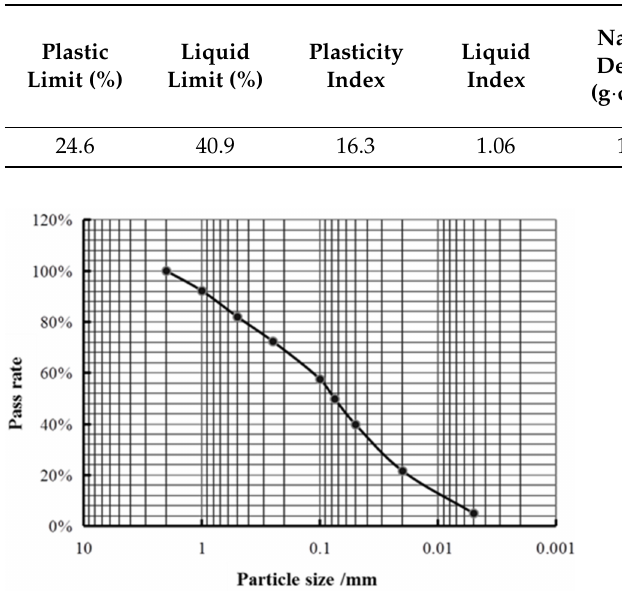
Figure 1. Gradation curve of soil sample.